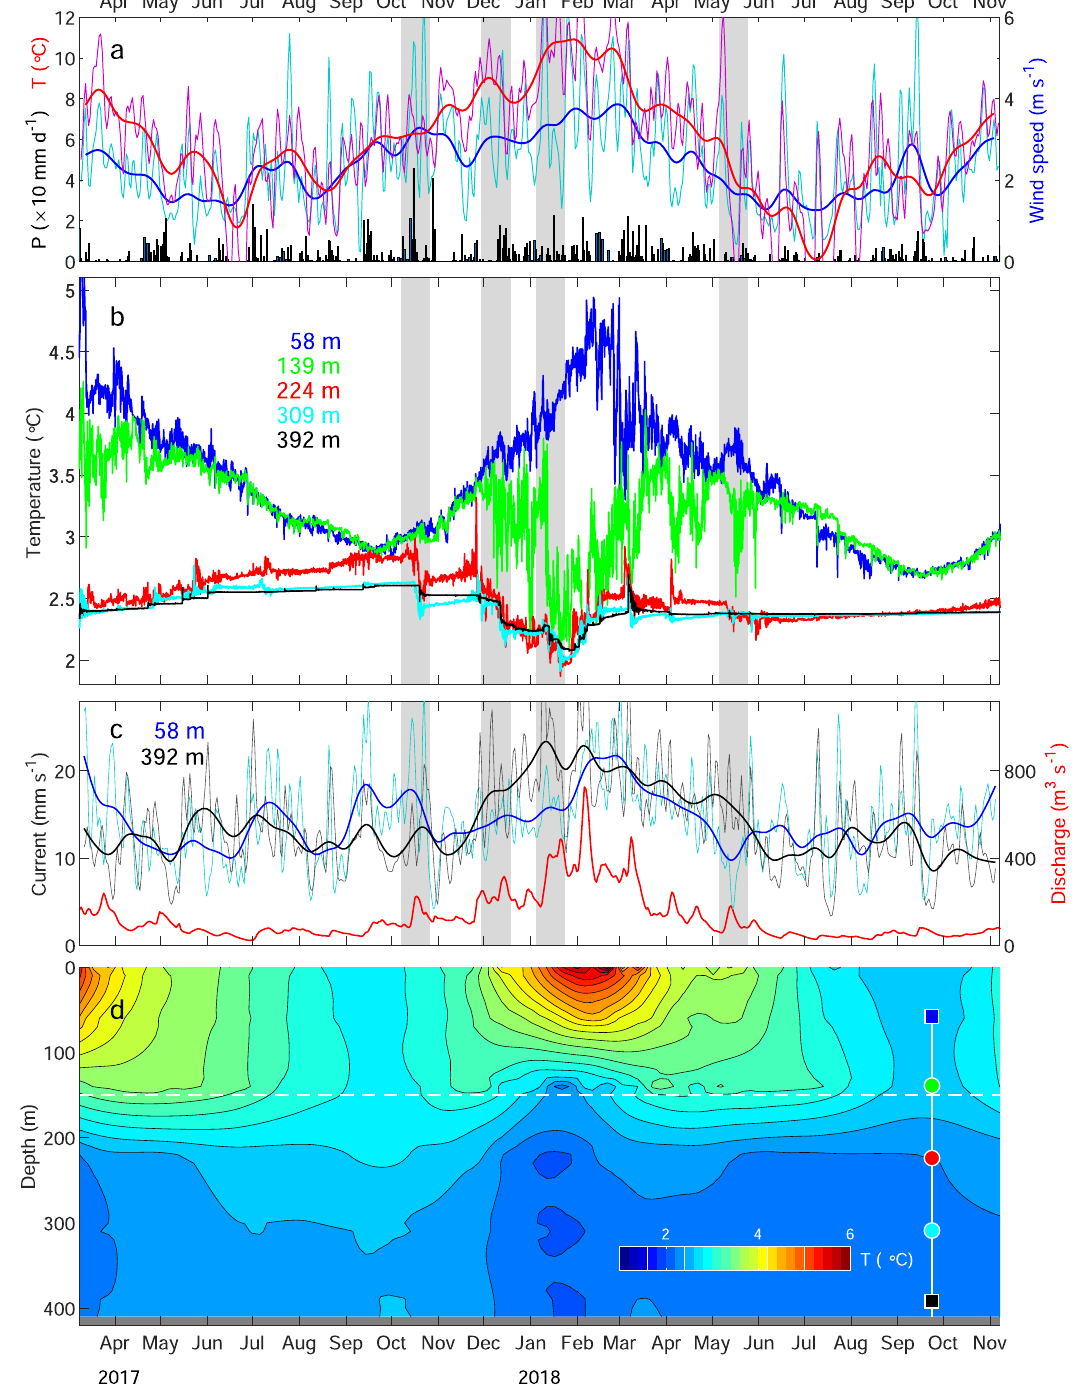
Fig. 3 Atmospheric, lake, and river observations from March 2017 to November 2018. a Air temperature (red), wind speed (blue), and daily liquid precipitation (black) obtained at the weather station (Fig. 1b). Hourly temperature and wind speed were fi ltered with 1-d (thin) and 1-week windows (thick). Grey shadings are time periods shown in Fig. 6. b Water temperature measured by mooring at the depths of 58 (blue), 139 (green), 224 (red), 309 (cyan), and 392 m (black) (Figs. 1b and 2e). c Current speeds measured by mooring at the depths of 58 (blue) and 392 m (black), and discharge of Río Grey (red) recorded at the station indicated in Fig. 1a. Currents were fi ltered with 1-d (thin) and 1-week windows (thick). d Water temperature distribution obtained by interpolating the data in ( b ). The temperature was linearly extrapolated to the regions above 58 m and below 392 m. Contour intervals are 0.2 °C. The horizontal dashed line indicates the depth of the sill shown in Figs. 1b and 2e. Markers show the depths of the temperature ( ● ) and current/temperature sensors ( ■ ) with colors corresponding to the line colors in ( b ) and Fig. 6e –